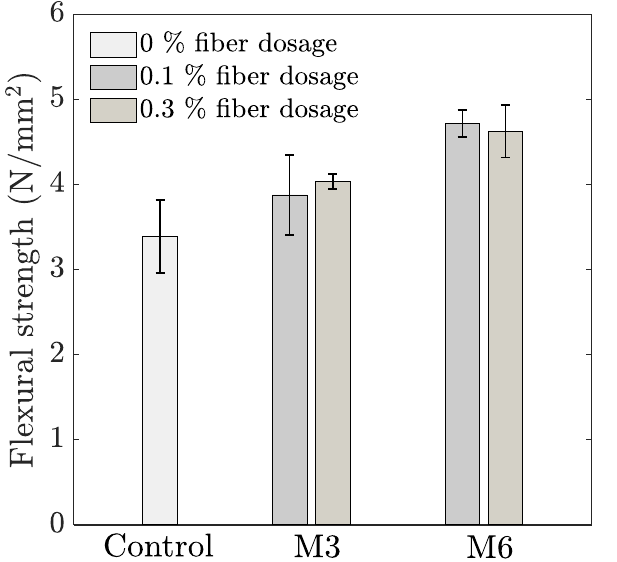
Figure 6. Influence of fiber addition on average 28-day flexural strength (error bar represents the standard deviation, n = 3).